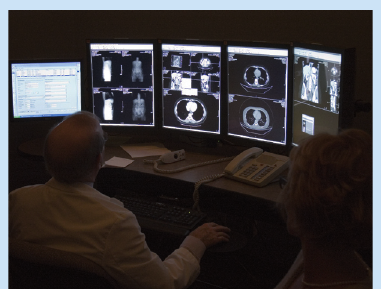
Fig. 4. One colour monitor and four black-and- white monitors. Note the differences in height between the displays and the input devices (mouse and keyboard).